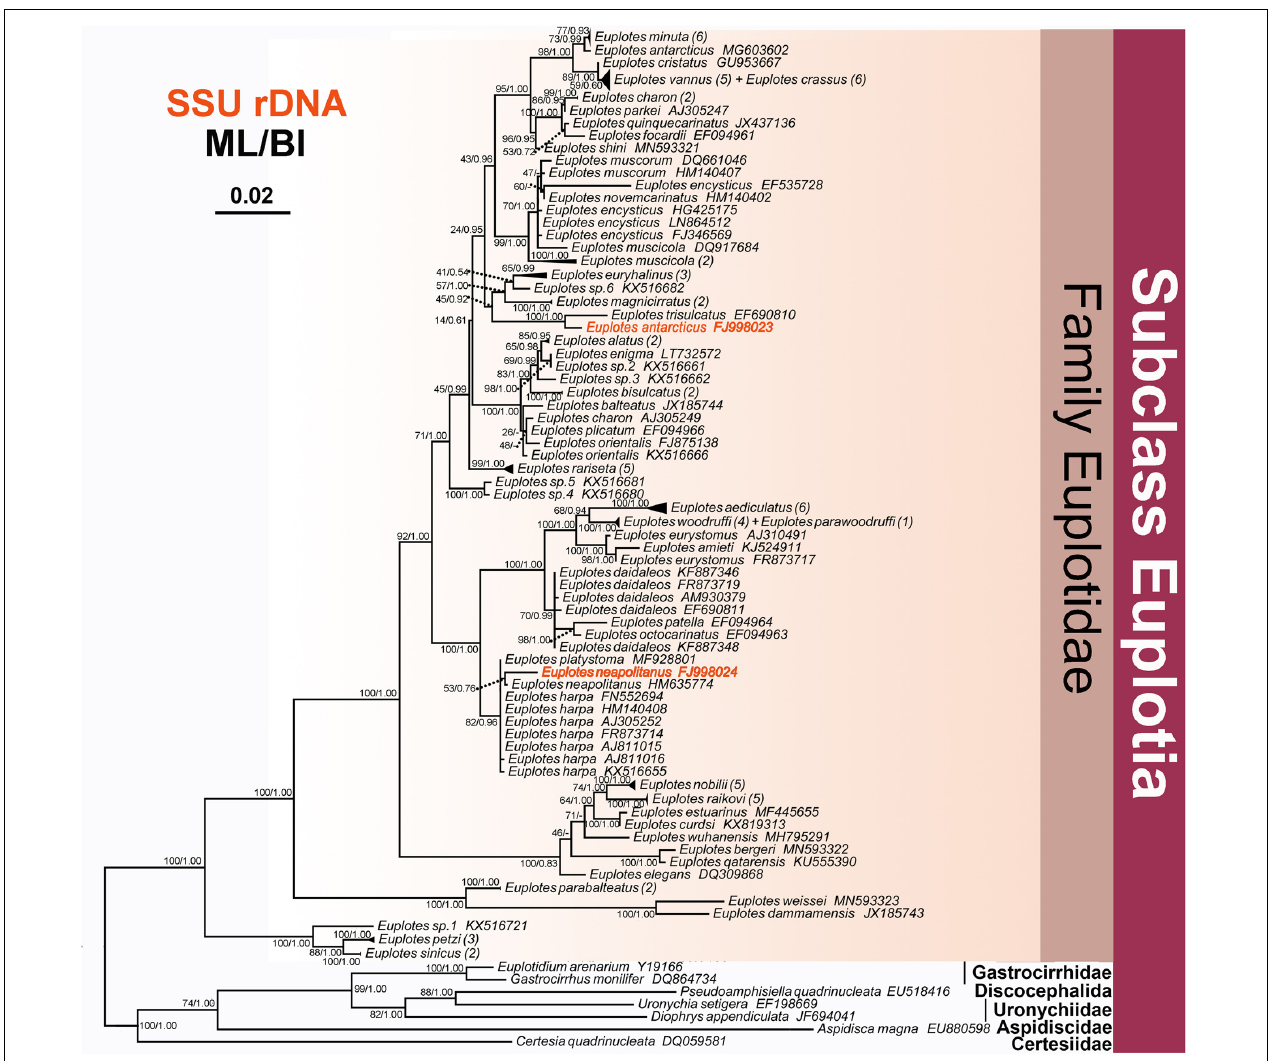
FIGURE 5 | The Maximum likelihood (ML) tree inferred from 18S rRNA gene sequences, showing the position of E. neapolitanus and E. antarcticus . Numbers in the brackets mark the number of populations for each species. Numbers at nodes represent the bootstrap values of the ML analysis and the posterior probability of the Bayesian inference (BI) analysis. “–” indicates topologies that differ between the ML and BI phylogenies. Scale bar corresponds to five substitutions per 100 nucleotide positions.